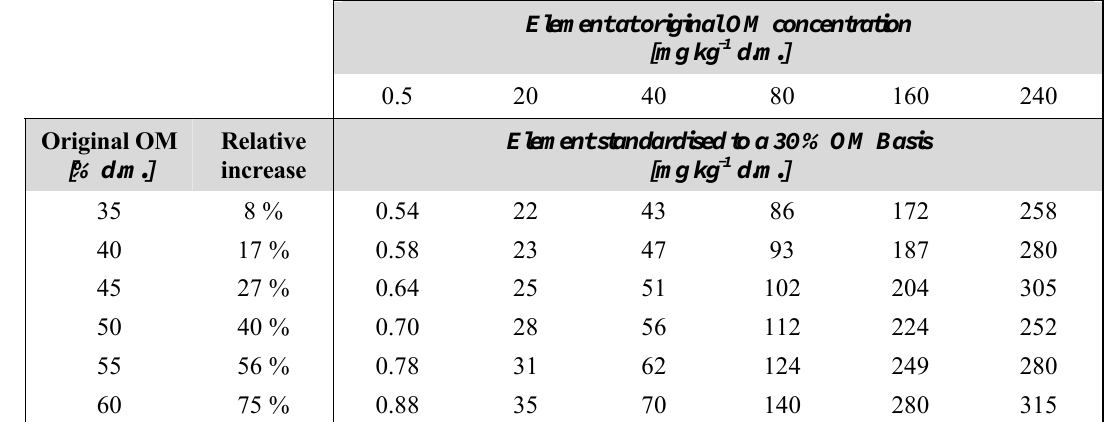
Relative and absolute increase of concentration values if the measured concentration is standardised to a 30 % OM level assuming different actual levels of OM in compost Element at original OM concentration [mg kg -1 d.m.] Original OM Element standardised to a 30 % OM [% d.m.] increase